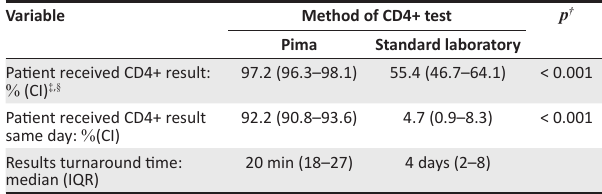
TABLE 3: Comparison of outcomes for point-of-care Pima CD4+ testing with outcomes for standard laboratory CD4+ testing method, Namibia,